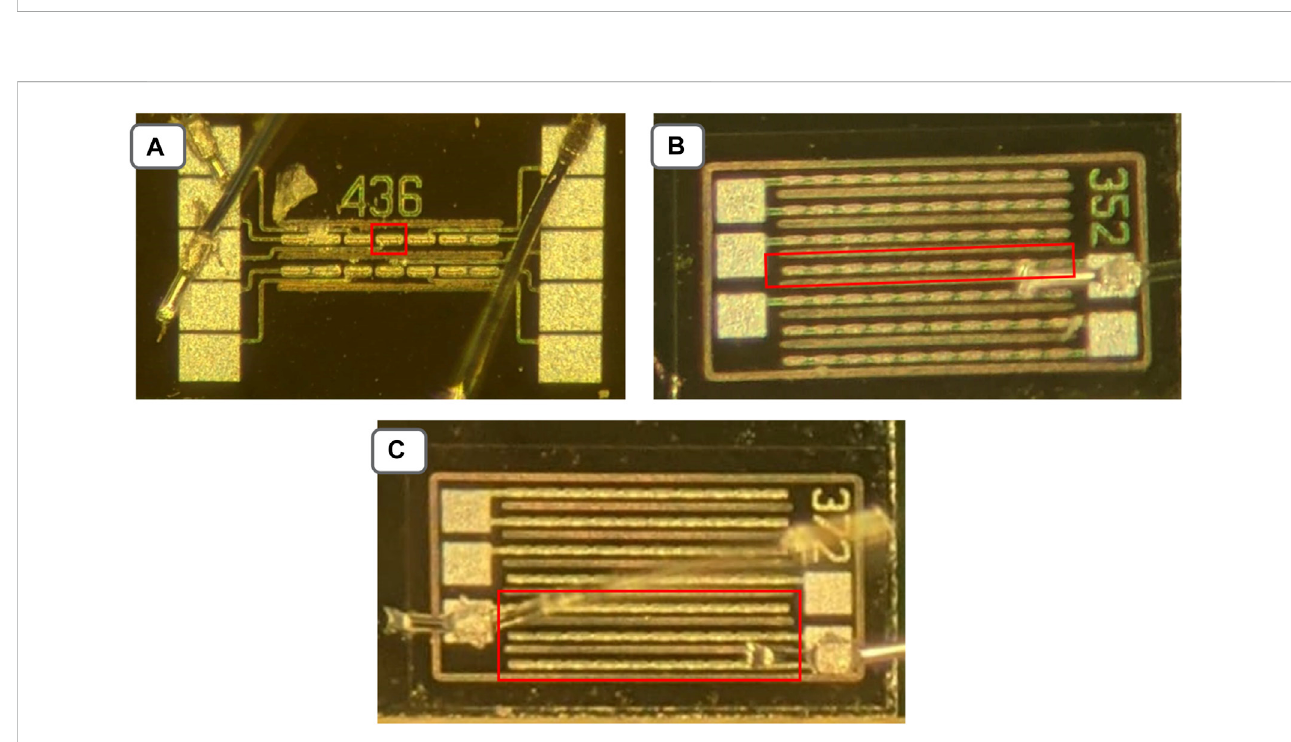
FIGURE 2 Pictures of some of the 3D-trench pixel test structures used in this work. For each structure the active area is outlined in red. (A) Single pixel sensor; (B) strip sensor (10 adjacent pixels located on the same row); (C) triple strip sensor (30 pixels located in three adjacent